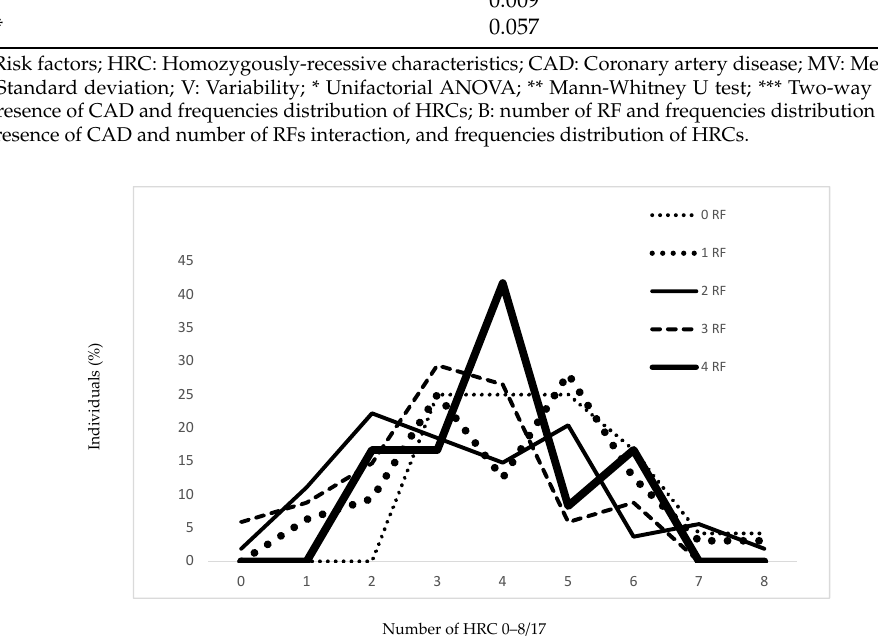
Figure 2. Frequencies of homozygous recessive characteristics in the control sample regarding number of risk factors. RF: risk factor; 0 RF: N = 24 (15.4%); 1 RF: N = 32 (20.5%); 2 RFs: N = 54 (34.6%); 3 RFs: N = 34 (21.8%); 4 RFs: N = 12 (7.7%).